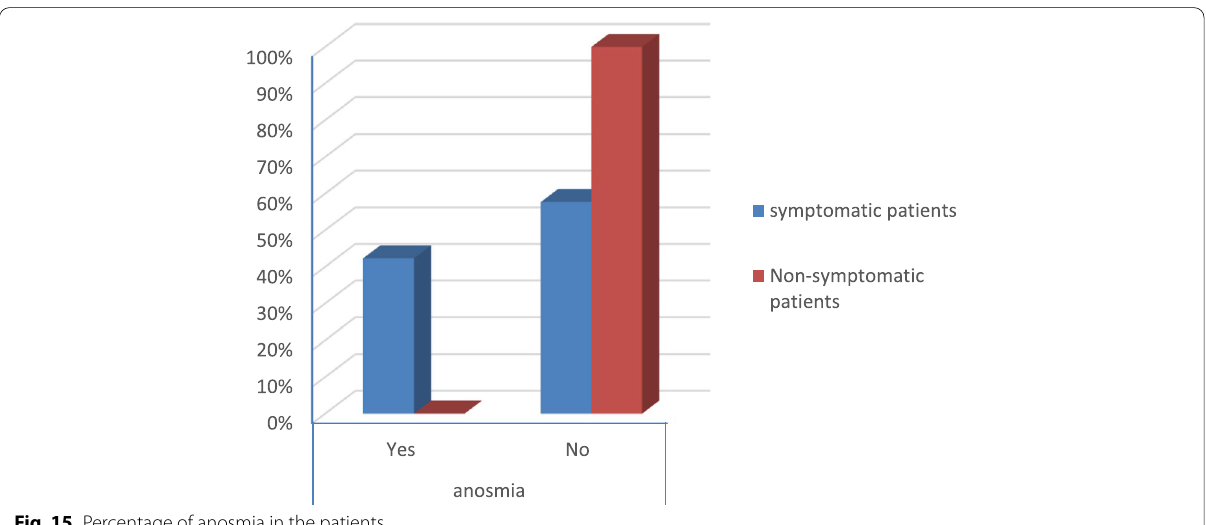
Fig. 15 Percentage of anosmia in the